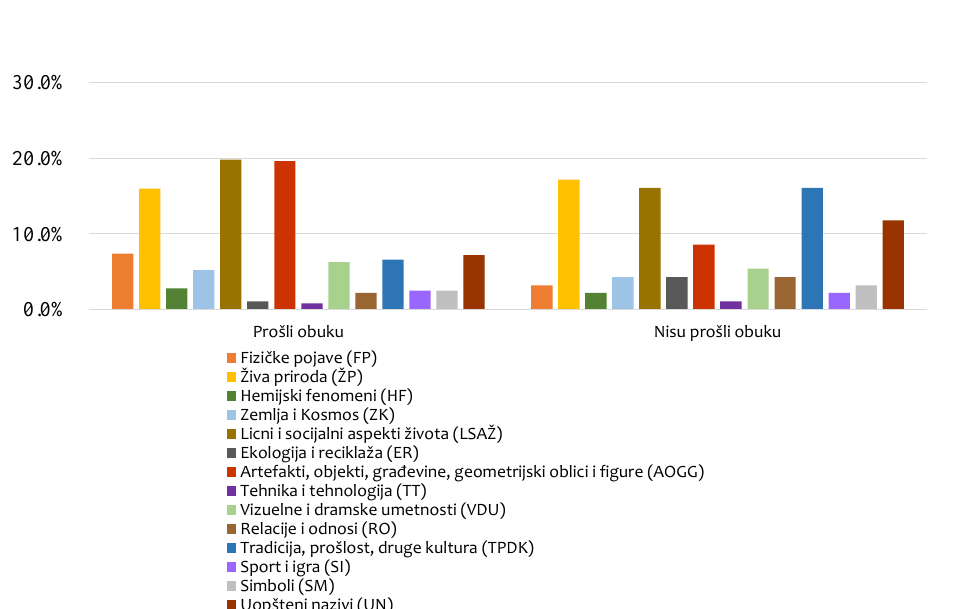
Grafikon 3. Čime se deca i vaspitači bave u zajedničkom radu na temama/projektima Rezultati istraživanja su pokazali da najviše tema/projekata pripada kategoriji LSAŽ (19,1%), AOGG (17,3%) i ŽP (16,2%). U manjoj meri prisutne su teme/projekti koji pripadaju kategoriji TPDK (8,6%), FP (6,6%), VDU (6,1%) i ZK (5,0%). Najmanje su prisutne teme/projekti koji pripadaju kategoriji HF (2,6%), RO (2,6%), SM (2,6%), SI (2,4%), ER (1,8%) i TT (0,9%). Značajno je napomenuti su da u značajnom procentu (8,1%) i dalje prisutne teme/projekti koji ne sadrže suštinsko pitanje koje podstiče na zajedničko istraživanje jer su to teme uopštenih naziva karakterističnih za realne programe prethodnih koncepcija ( Osećanja, Pitam se pitam, Šta sve umem i znam, Ćiribu - ćiriba, Ja kao pronalazač …) ili teme/projekti koji u svom nazivu sadrže načine učenja i činjenja dece ( Eksperimenti, Životno - praktične situacije, Pravimo …). Određene razlike jasno su uočljive kada se dobijeni rezultati analiziraju prema varijabli OPOP (Grafikon 3 ). Vaspitači koji su prošli obuku za primenu Osnova programa u trenutku realizacije ovog istraživanja radili su zajedno sa decom, a u odnosu na vaspitače koji nisu prošli obuku, u nešto većoj meri na temama/projektima iz kategorije AOGG i LSAŽ. Vaspitači koji nisu prošli obuku za primenu Osnova programa u trenutku realizacije ovog istraživanja radili su zajedno sa decom, a u odnosu na vaspitače koji jesu prošli obuku, u nešto većoj meri na temama/projektima iz kategorije TPDK i ER. Takođe, među temama/projektima koje su razvijali vaspitači koji nisu prošli obuku značajno je više tema/projekata uopštenog naziva. Izračunavanjem 2 testa pokazalo se da su uočene razlike statistički značajne: 2 =23,695; df=13; p=0,034). Rezultati pokazuju da su vaspitači koji su prošli obuku u većoj meri započeli sa razvijanje m tema/projekata koji